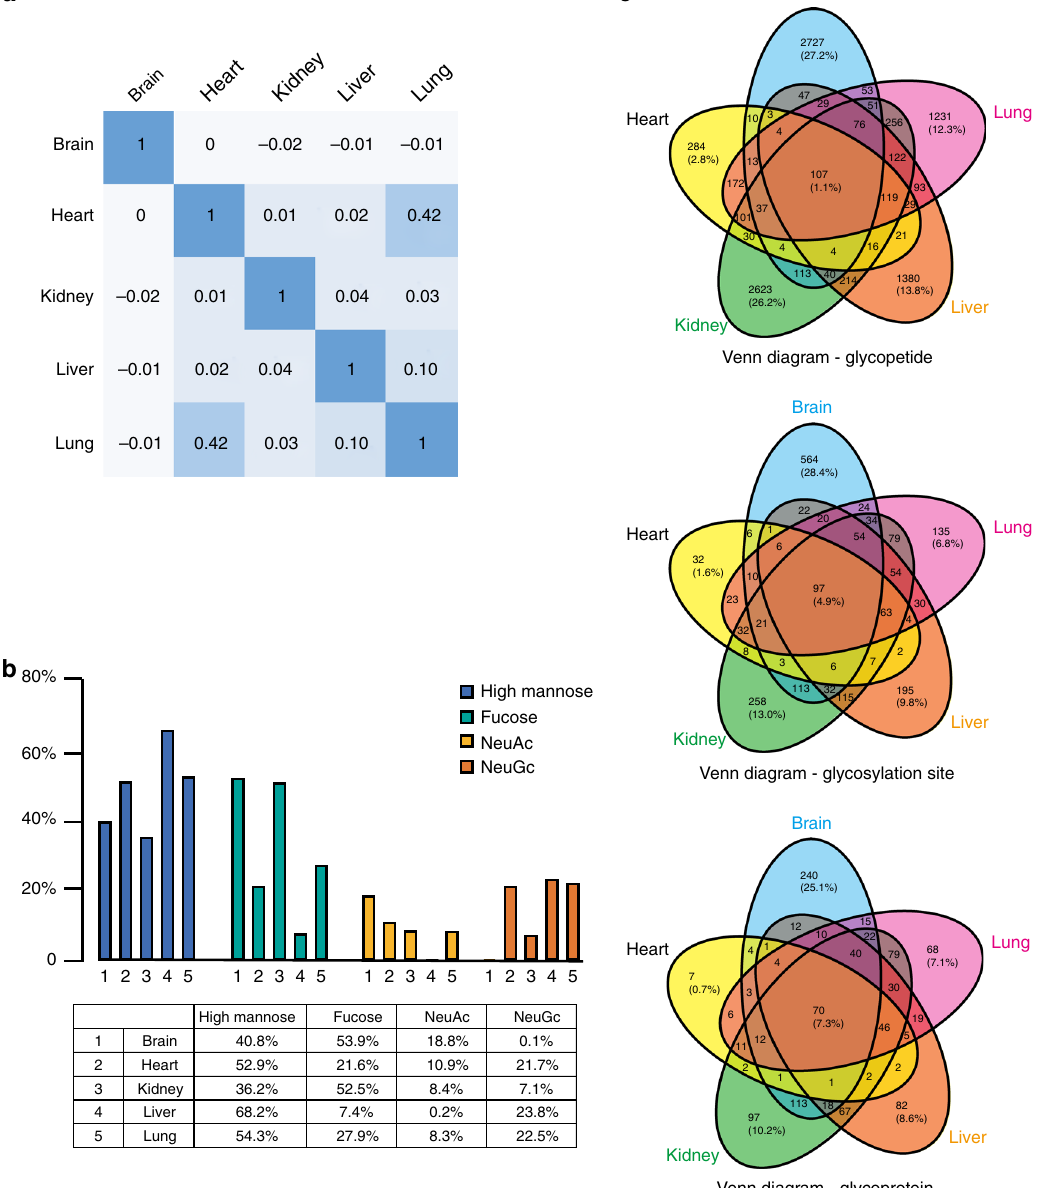
Fig. 7 Analysis of the glycosylation pro fi les in different mouse tissues. a Correlation analysis of the glycopeptides in different tissues. b Distribution of glycopeptides containing high levels of mannose, fucose, NeuAc and NeuGc in different tissues. c Venn diagram of the unique glycopeptides, glycosylation sites and glycoproteins in different